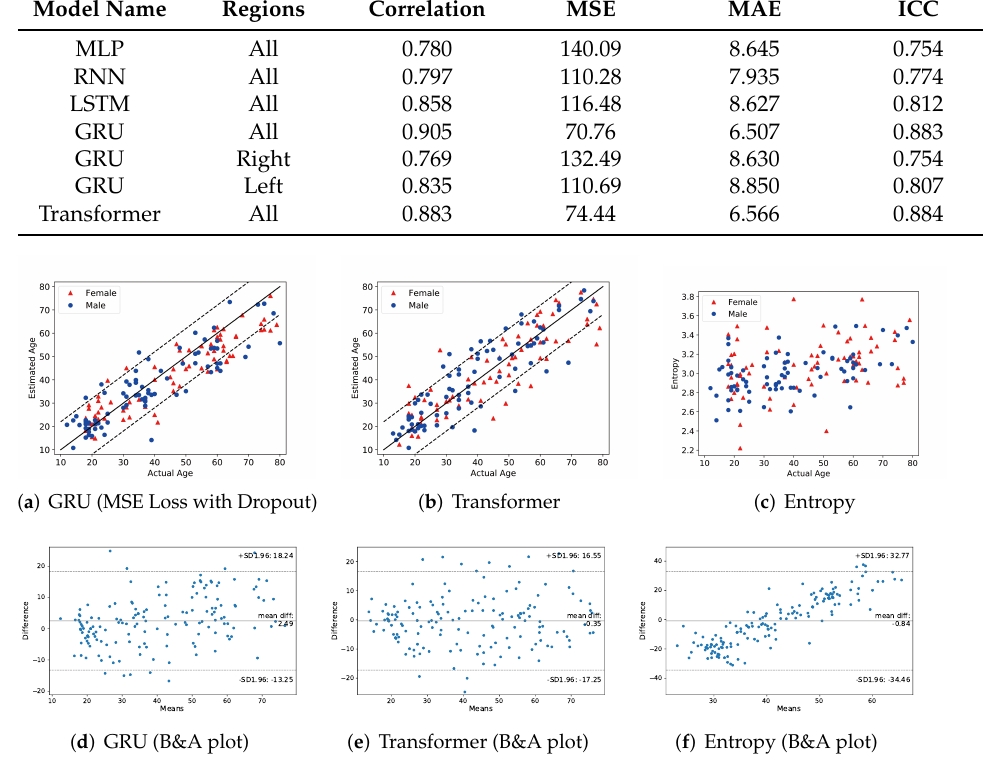
Figure 4. The first line of figures are age estimation results of the proposed GRU model and Trans- former model, and the relation between entropy and age. The x -axis represents the actual age of the subject whereas the y -axis represents the estimated age. ( a ) MSE loss function with dropout; ( b ) use Transformer encoder model; ( c ) relation between entropy and age. The solid line is the best diagonal when the actual age matches the estimated age. The dotted line refers to the deviation line 12 years away from the actual age. The second line of figures are the Bland–Altman (B&A) plot corresponding to the above. ( d ) Bland–Altman plot of GRU; ( e ) Bland–Altman plot of Transformer encoder model; ( f ) Bland–Altman plot of entropy. The x -axis is the average of each sample’s actual and predicted age, and the y -axis is the difference between the exact age and the predicted age of the sample. The solid line is the average of the difference. The dashed line is the upper and lower limits of 95% agreement, i.e., ± 1.96 standard